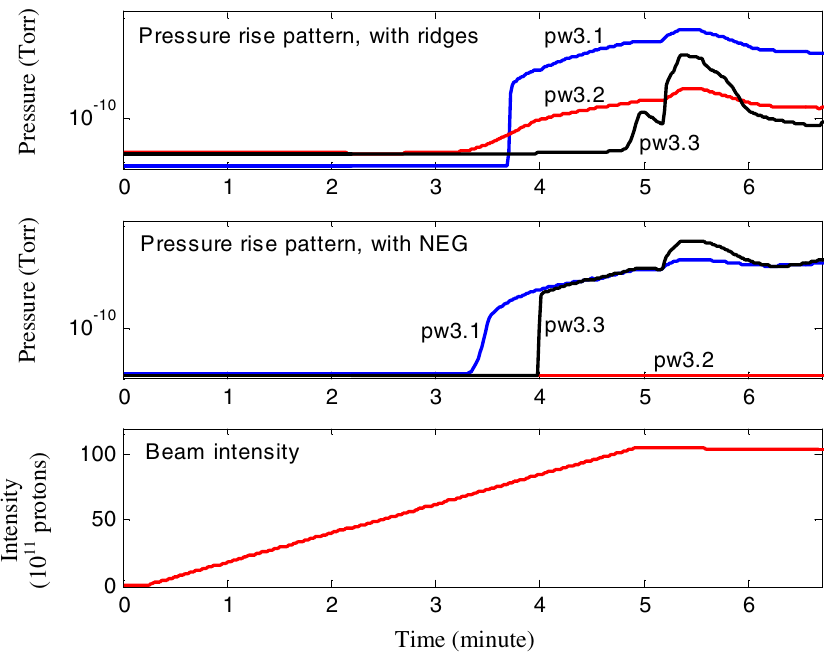
FIG. 9. (Color) Patterns of electron cloud induced pressure rise during injection. Bottom is the yellow beam injection in the 110-bunch mode, with 10 11 protons per bunch. The middle plot shows the electron cloud induced pressure rise at a fully NEG coated straight section. The blue and black lines are for pw3.1 and pw3.3, at the ends of the section, and the red line is for pw3.2, located in the center of the section. Note that the center of the section has the lowest pressure rise. The top plot shows the pressure rise at Yo5 with antigrazing ridges. Note that the pressure rise at the center of this straight section is low, similar to NEG covered